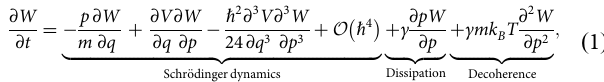
= 0.704 eV, reaction f